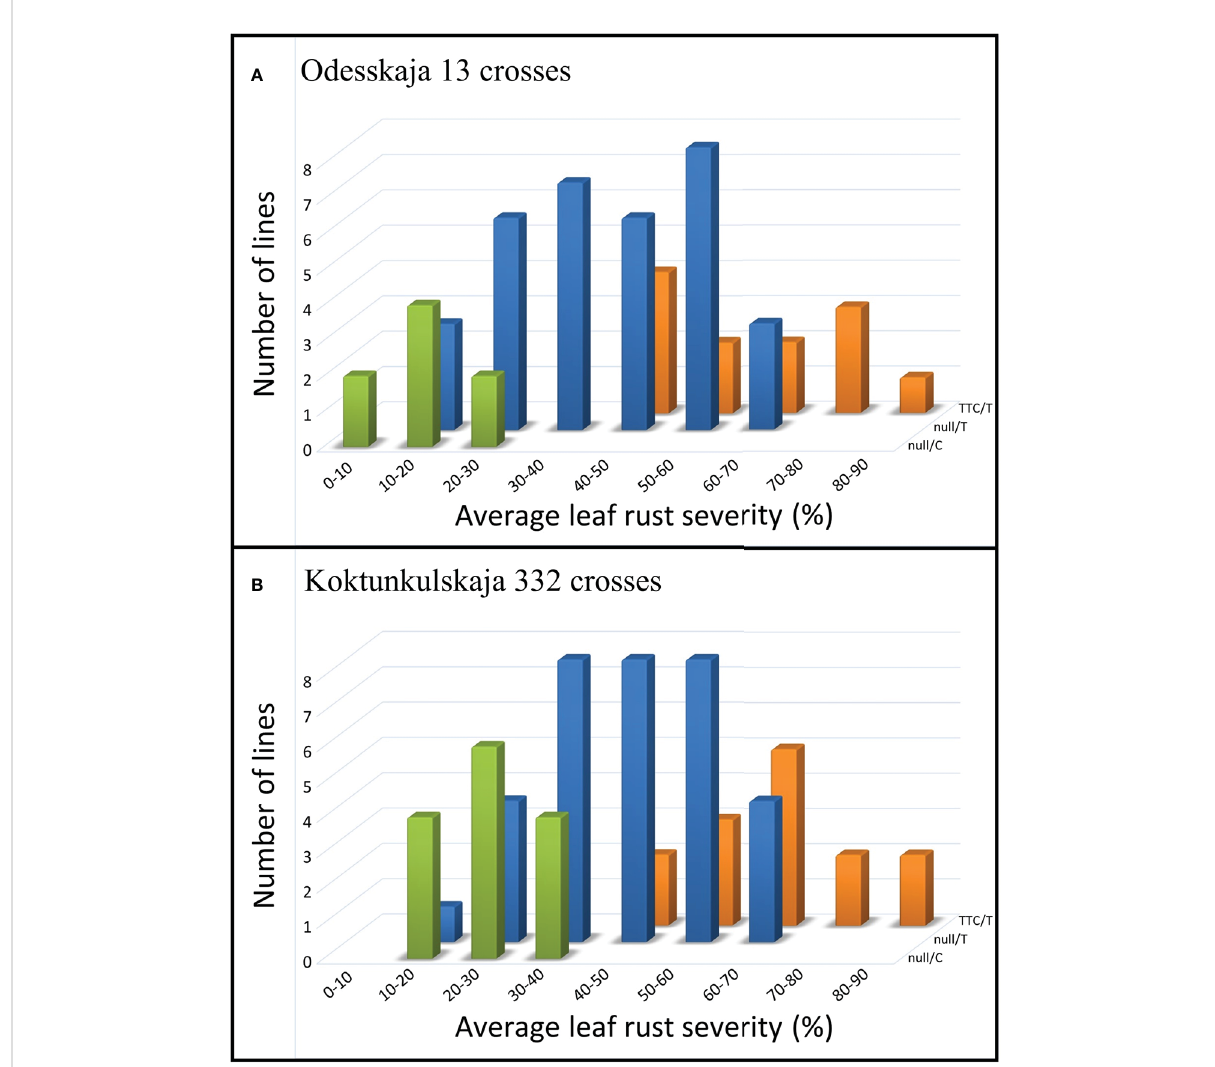
FIGURE 2 Average leaf rust severity (%) of lines from the Odesskaja 13 crosses (A) and the Koktunkulskaja 332 crosses (B) categorized according to their Lr34 haplotypes as de fi ned by their genotype at exons 11 and 12, namely null/C, null/T and TTC/T. Populations were tested in six environments over three years.